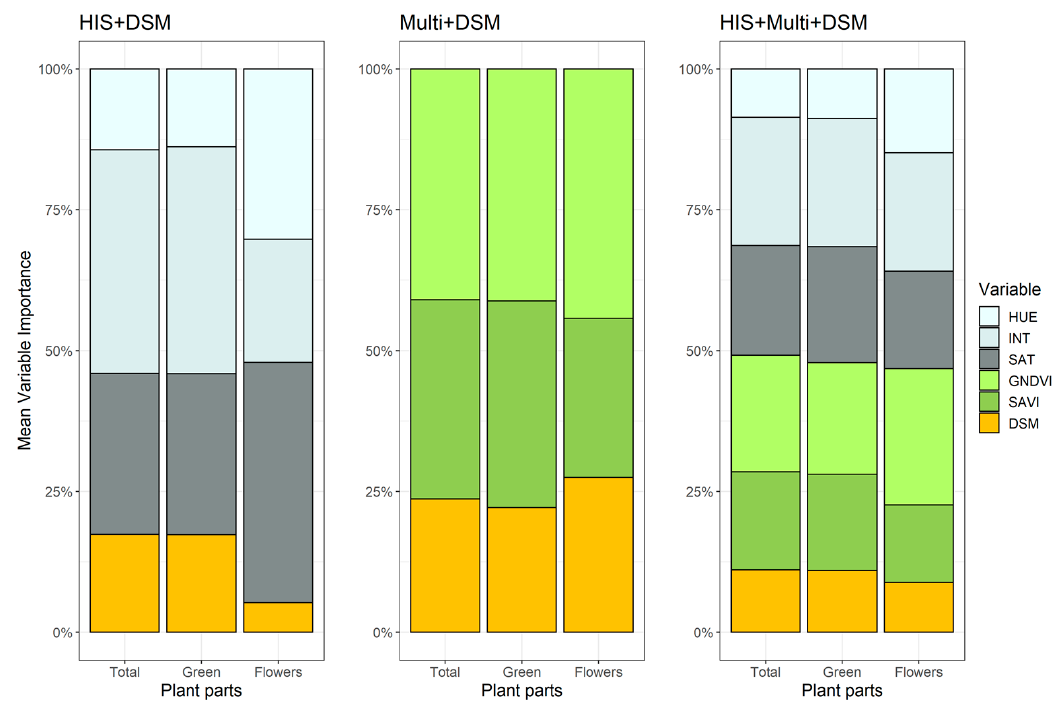
Figure 7. Importance of variables in different datasets and for different parts of the plant. Data for the intermediate calibration set (30%) are shown.